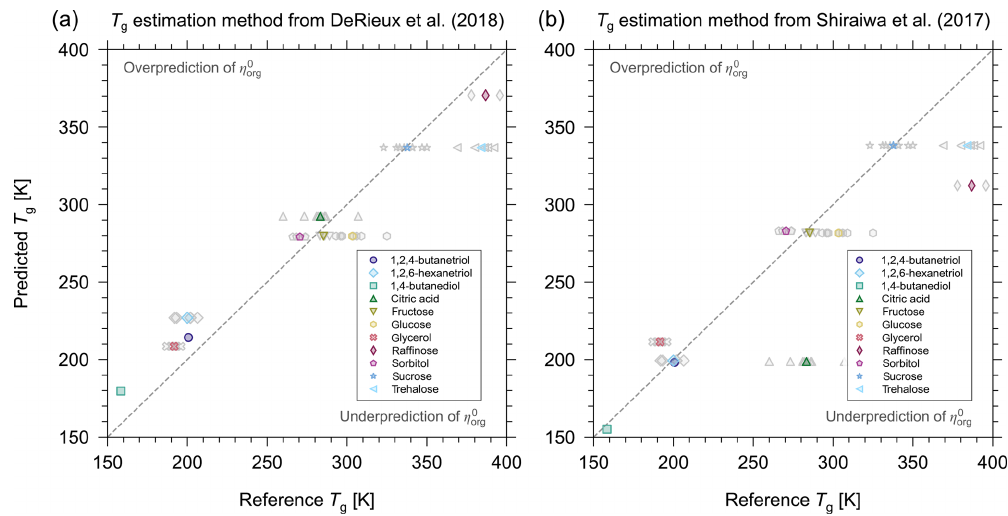
Figure 3. Prediction of T g using the methods presented in (a) DeRieux et al. (2018) and (b) Shiraiwa et al. (2017) versus measured reference T g values for some of the binary aqueous mixtures considered in this study. The grey markers represent individual reference T g values, and the coloured markers represent the average T g . Error bars for reference values have been omitted for clarity. For a list of the reference values and their uncertainties, see Table S1. The grey dashed 1 : 1 lines represent perfect agreement between predicted and reference